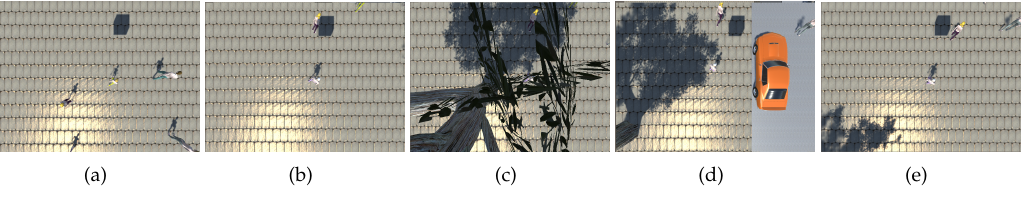
Figure 6. Image sequence of a group of pedestrians moving from the bottom left of the environment ( a ) to the top right ( e ) captured by a UAV surveying the scene.